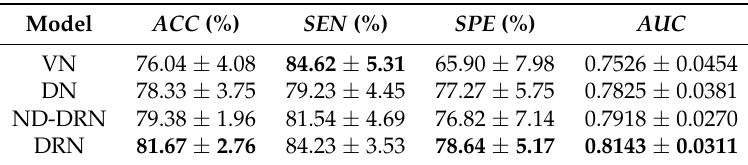
Table 4. Classification performance of different 3D models for T1 task.